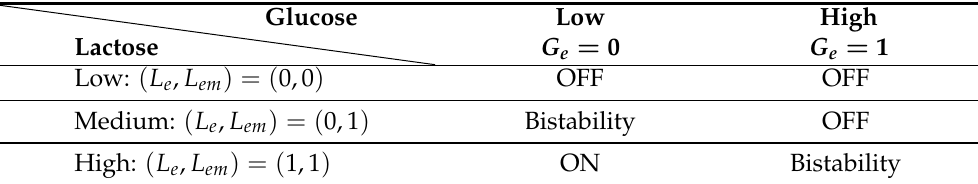
Table 6. The possible cases in the improved original and reduced models for each of the six combina- tions of